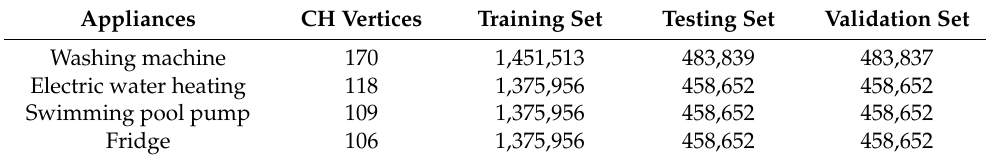
Table 4. Size of training, testing, and validation